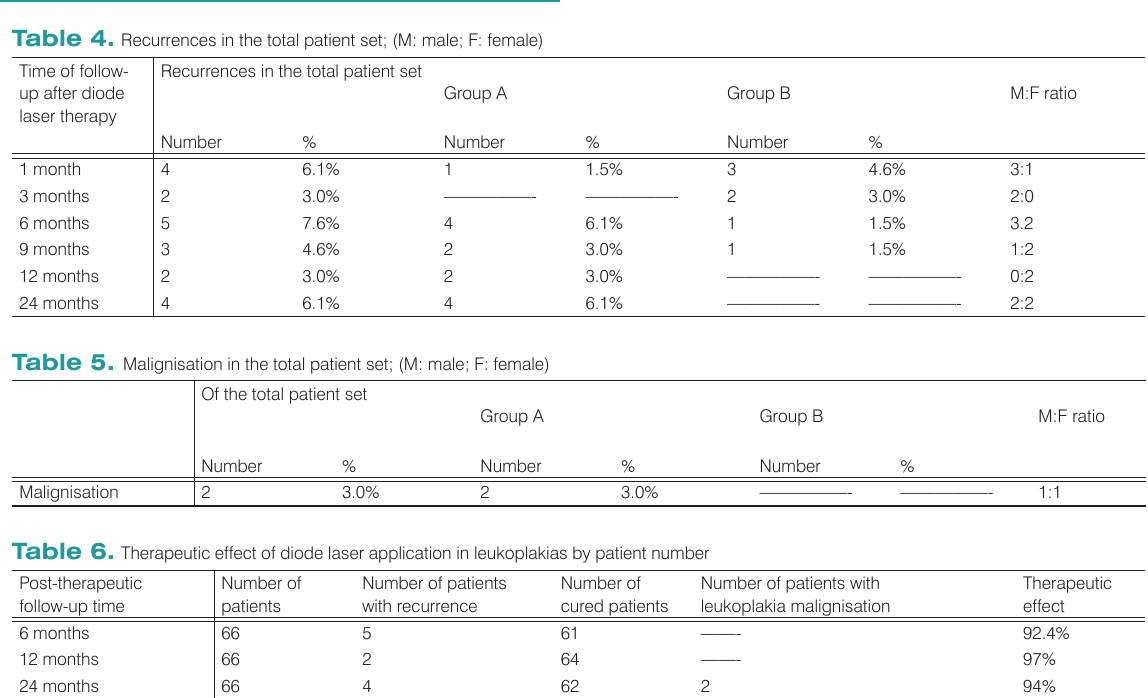
Table 7. Therapeutic effect of diode laser application in leukoplakias by lesion number Post-therapeutic follow-up time